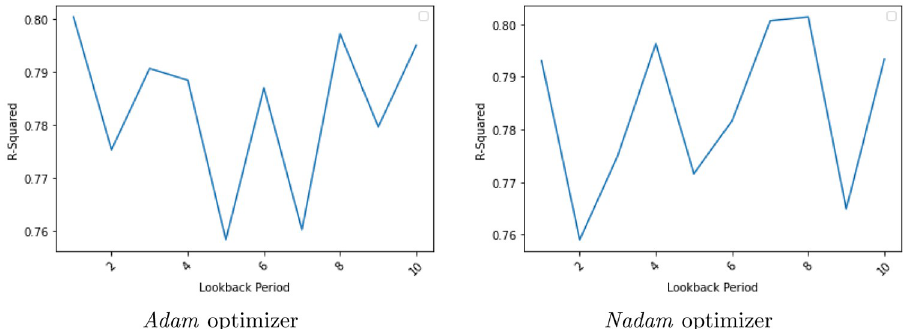
Fig 14. Lookback comparison of Nadam and Adam optimizers. We can see that the best R-squared is found corresponding to a lookback period of 1 day for the “ Adam ” optimizer and a lookback period of 8 days for the “ Nadam ”